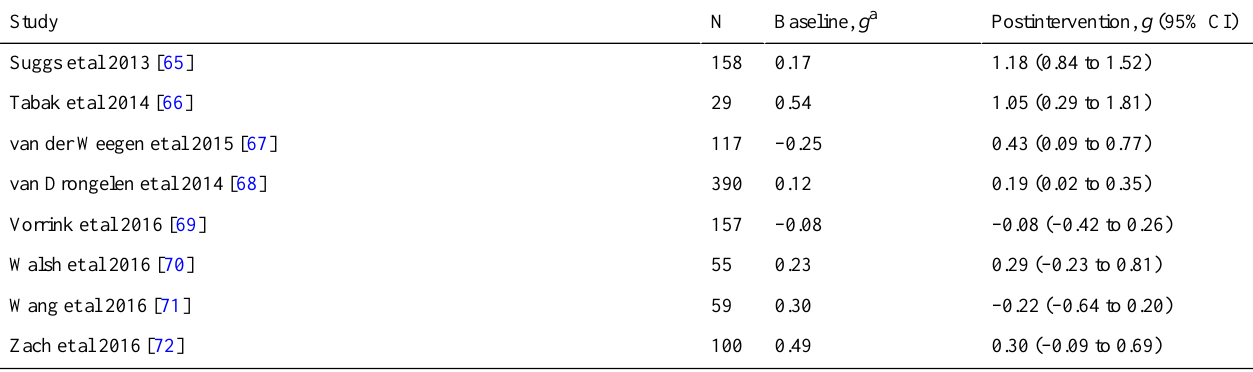
Table 2. The number of studies using each tested behavior change technique overall and split for the way in which physical activity was measured.